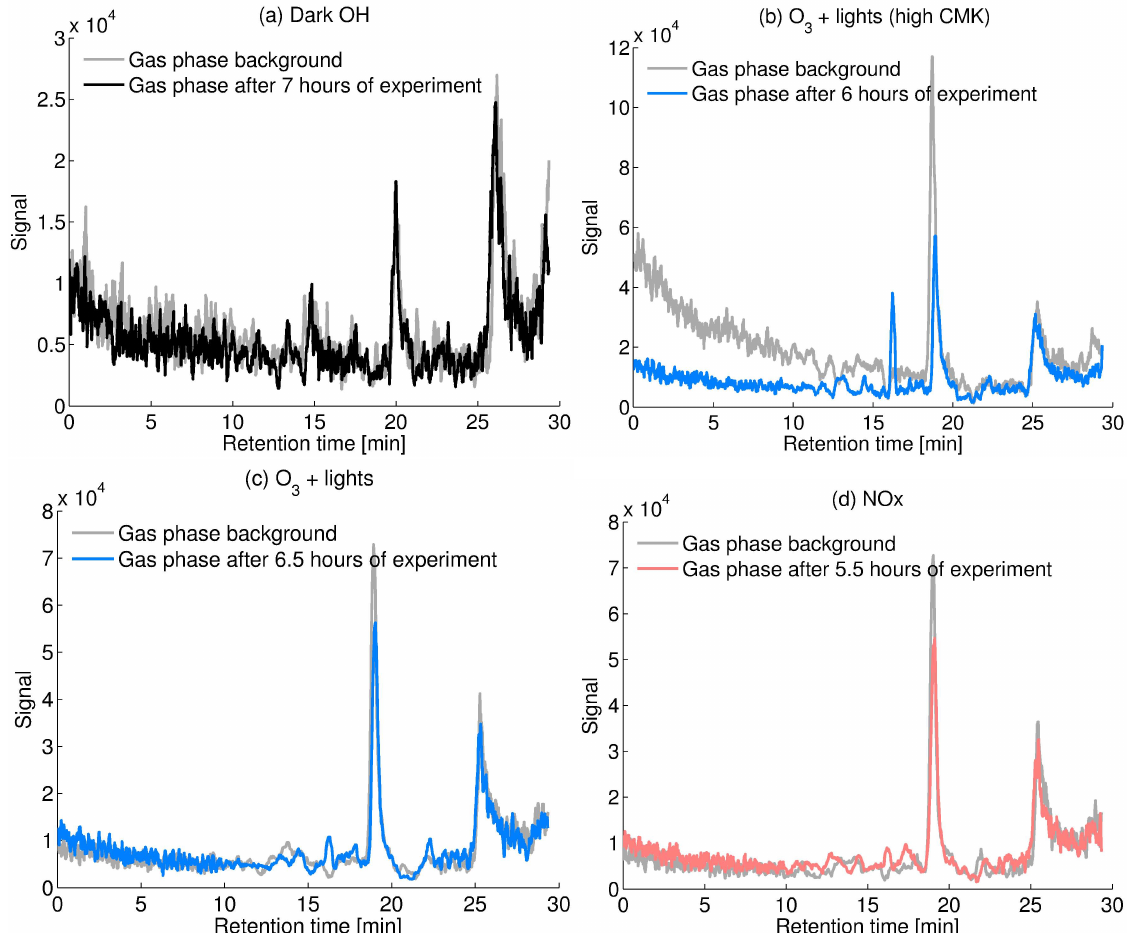
(cid:5) OH) production (b) ozone (O 3 ) photolysis